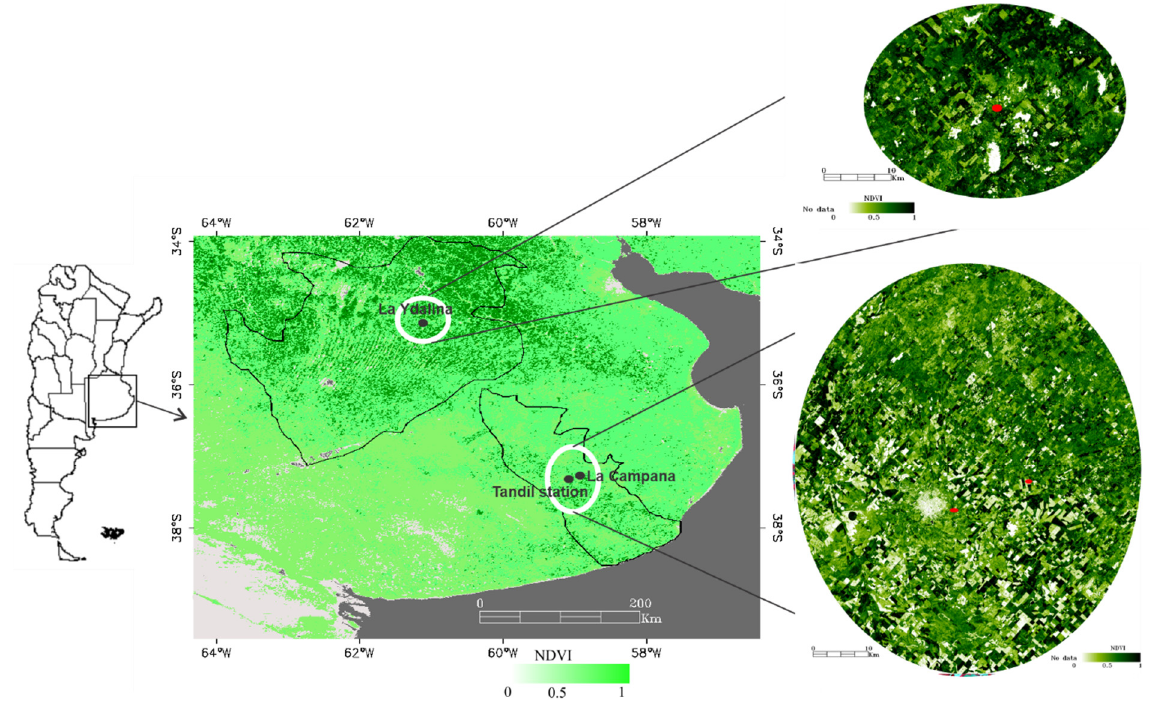
Figure 2. Location of the Argentine Pampas and the three test sites where field measurements were carried out (red circles). Left : maps of NDVI from MODIS/Aqua, right : NDVI from Landsat 8 (date: 2 January 2019).